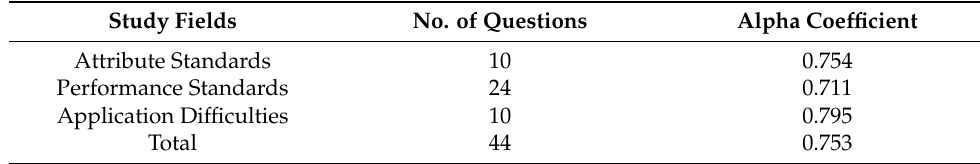
Table 2. Values for reliability coefficients.